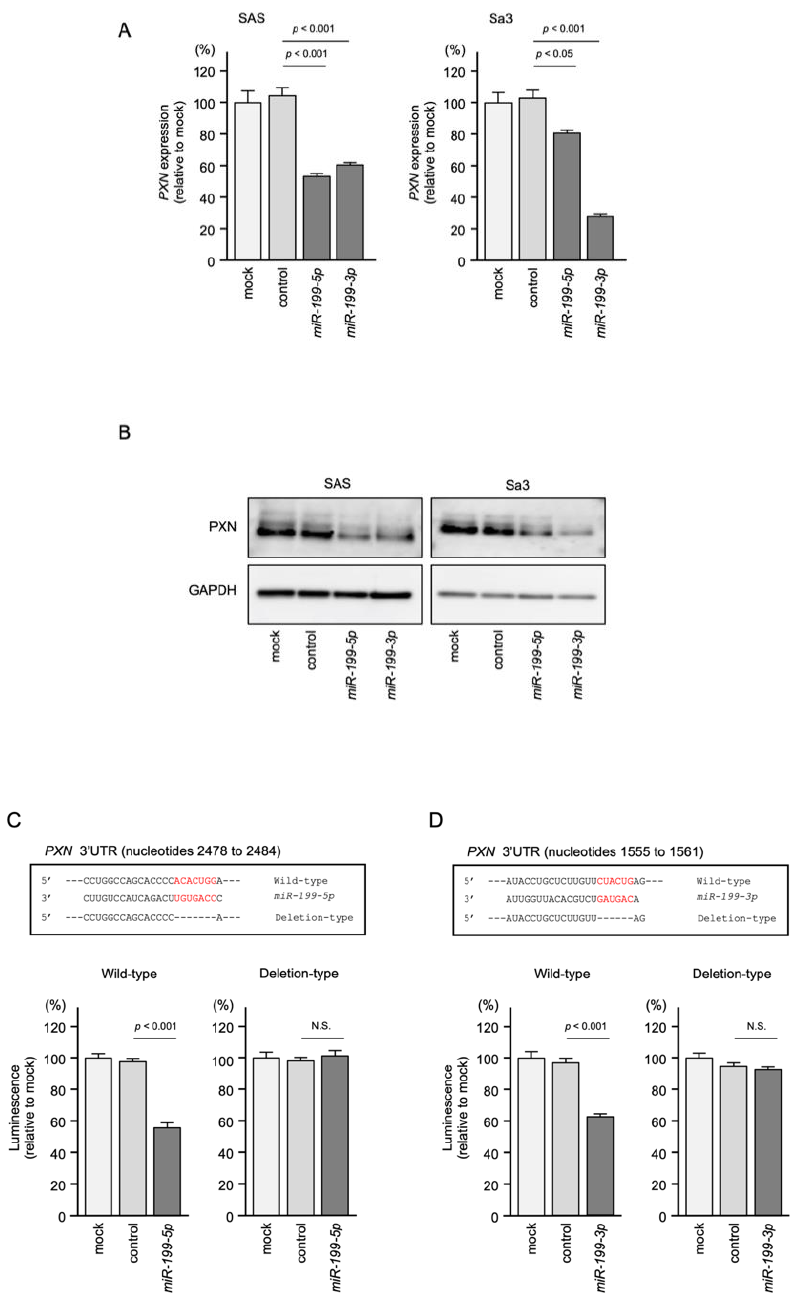
Figure 5. Direct regulation of PXN expression by both miR-199-5p and miR-199-3p in HNSCC cells. ( A ) qRT-PCR showing significantly reduced expression of PXN mRNA at 72 h after miR-199-5p or miR-199-3p transfection in SAS and Sa3 cells. Expression of GAPDH was used as an internal control. ( B ) Western blot showing reduced expression of PXN protein at 72 h after miR-199-5p or miR-199-3p transfection in SAS and Sa3 cells. Expression of GAPDH was used as an internal control. ( C ) TargetScan database analysis predicting a single putative miR-199-5p -binding site in the 3′-UTR of PXN (upper panel). Dual luciferase reporter assays showed reduced luminescence activity after cotransfection of the wild-type vector and miR-199-5p in SAS cells (lower panel). Normalized data are expressed as the Renilla/Firefly luciferase activity ratio (N.S., not significant). ( D ) TargetScan database analysis predicting a single putative miR-199-3p -binding site in the 3′-UTR of PXN (upper panel). Dual luciferase reporter assays showed reduced luminescence activity after cotransfection of the wild-type vector and miR-199-3p in SAS cells (lower panel).